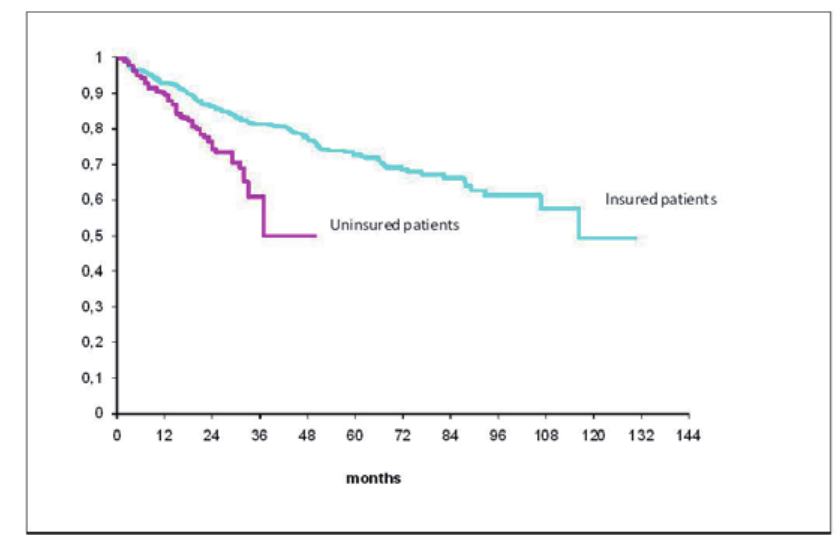
Figure 1 - Kaplan-Meier disease free survival